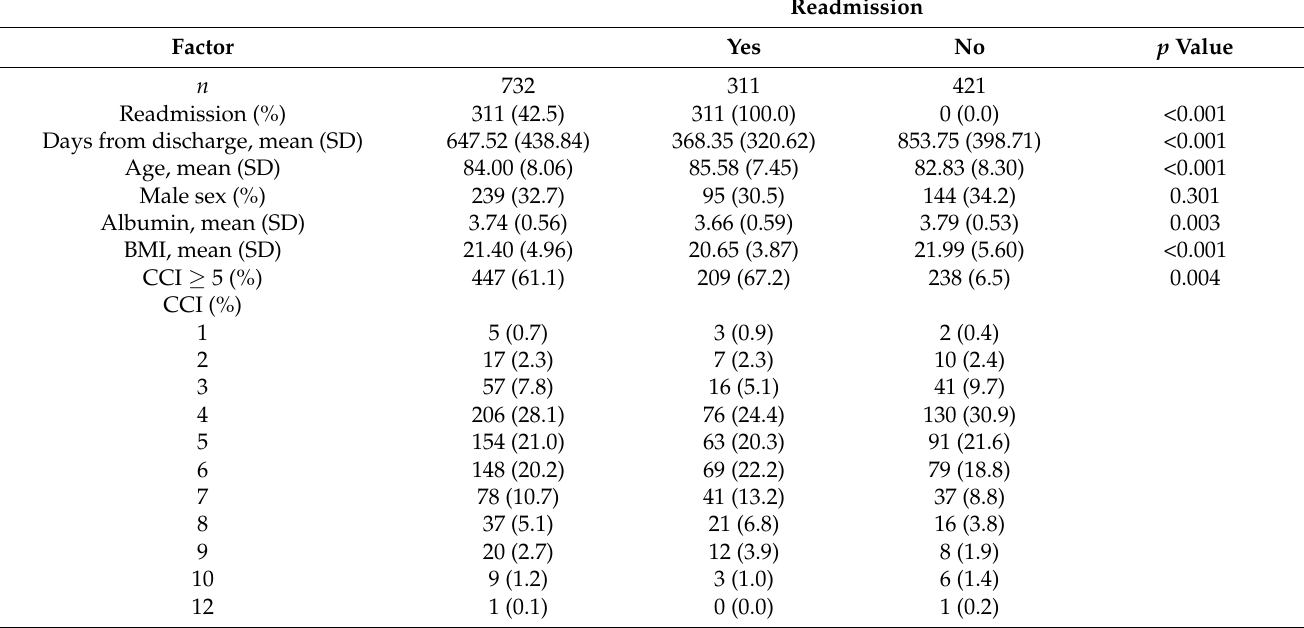
Table 1. Patient Table 1. Patient characteristics.